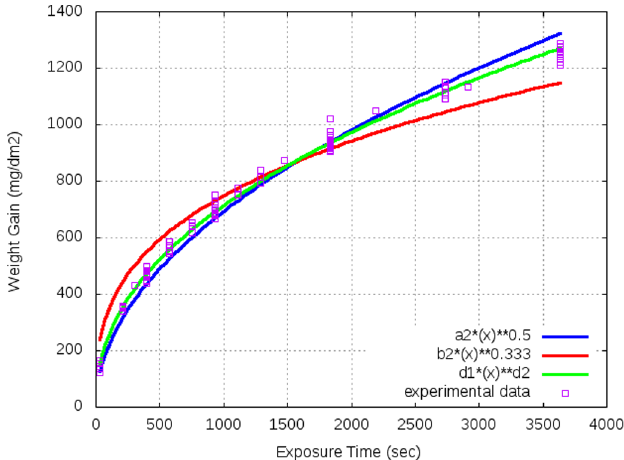
Fig. 2. Optimal oxidation kinetics (quadratic, cubic, and power- law function) for each maximal exposure time value, temperature 1050 ° C.